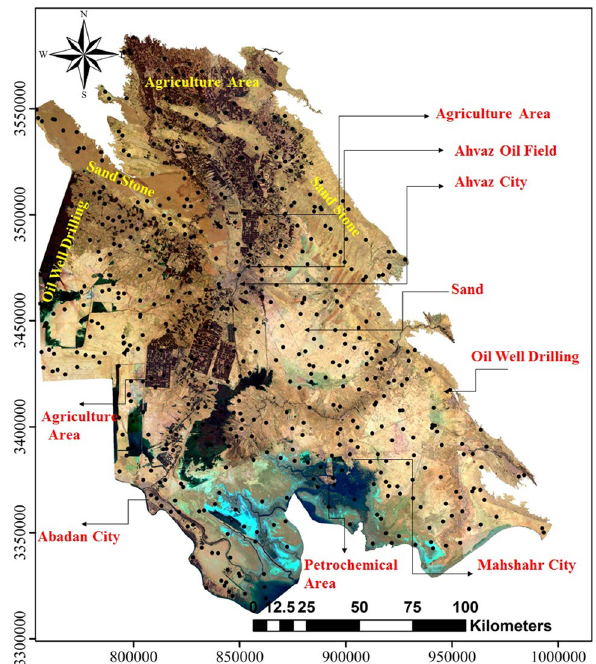
Figure 1. Satellite image of study area (Khuzestan plain) and sampling points, the image was made by ArcGIS10.2, background from Google Earth (Image: Google,